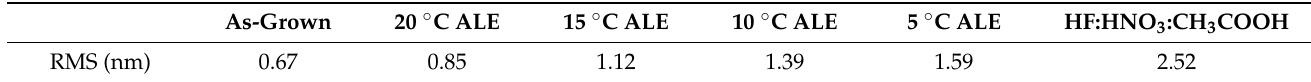
Table 1. RMS of flat (100) Ge surfaces with as-grown film and different etching processes. As-Grown